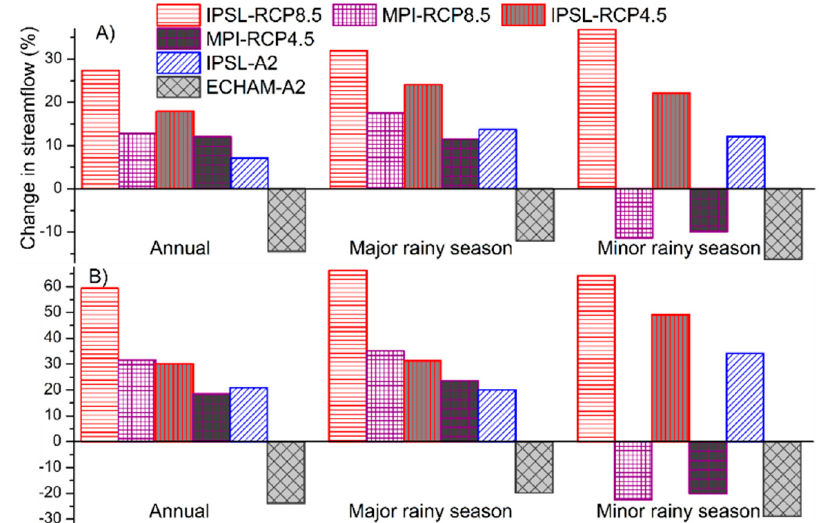
Figure 13. Percentage changes of annual and seasonal streamflow for ( A ) the near future period of 2021–2050 and ( B ) the far future period of 2071–2100, with reference to the baseline.